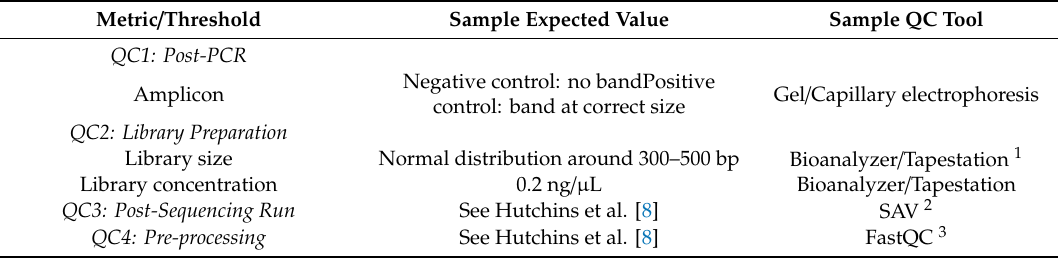
Table 1. A summary of performance metrics and thresholds at each quality control